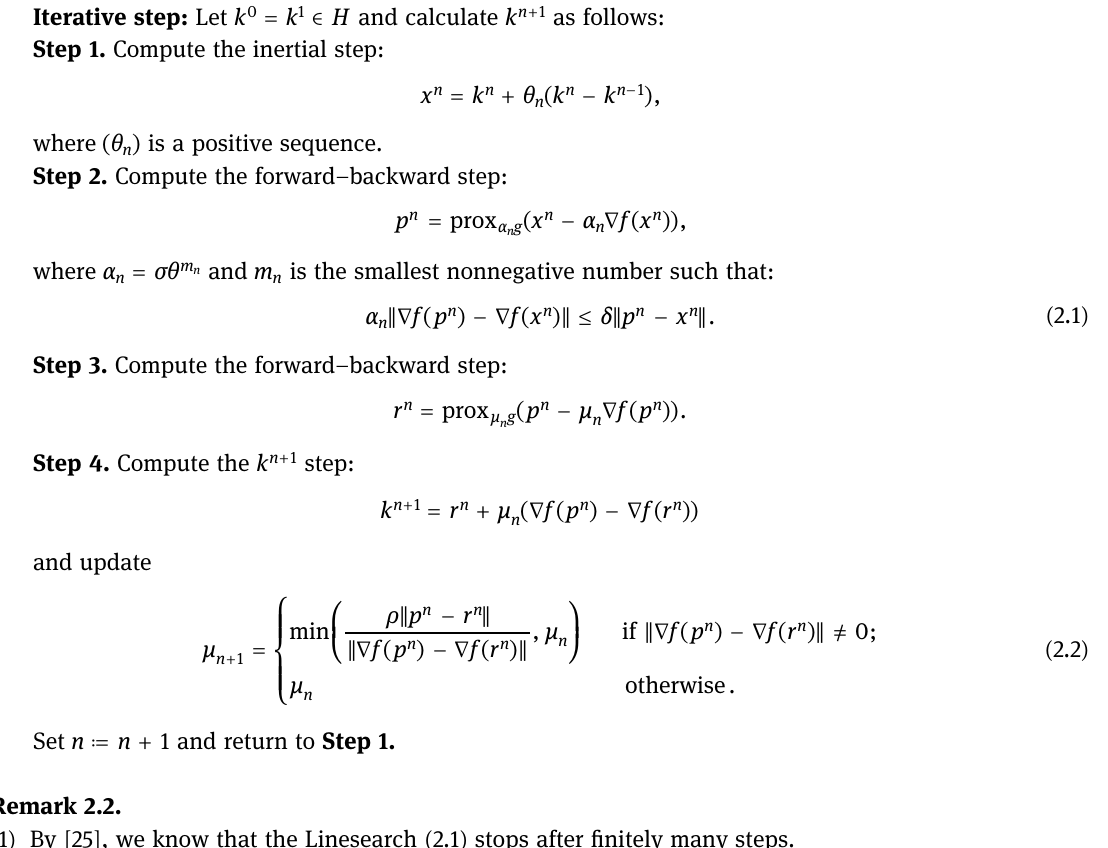
Algorithm 2.1. The inertial modi fi ed FBS ( IMFBS )